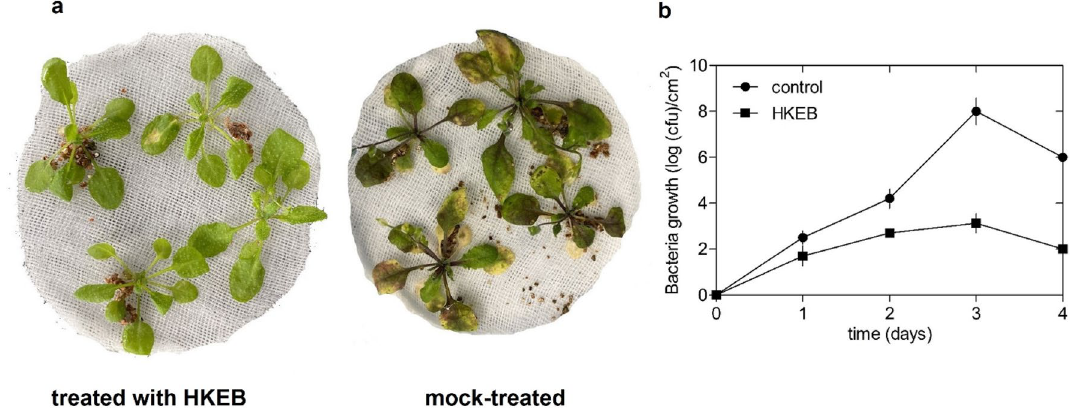
Figure 7. HKEB from B. aryabhattai induce an effective defense against P. syringae pv. tomato DC3000 strains in Arabidopsis plants. ( a ) Disease symptom evaluation in Arabidopsis plants that were treated with HKEB and mock-treated 1 week post-inoculation. ( b ) Bacterial growth in Arabidopsis plants. The multiplication of Pst in Arabidopsis leaves was plotted on a log scale. The bars represent the mean values and standard errors of the means (n = 10). The experiments were replicated three